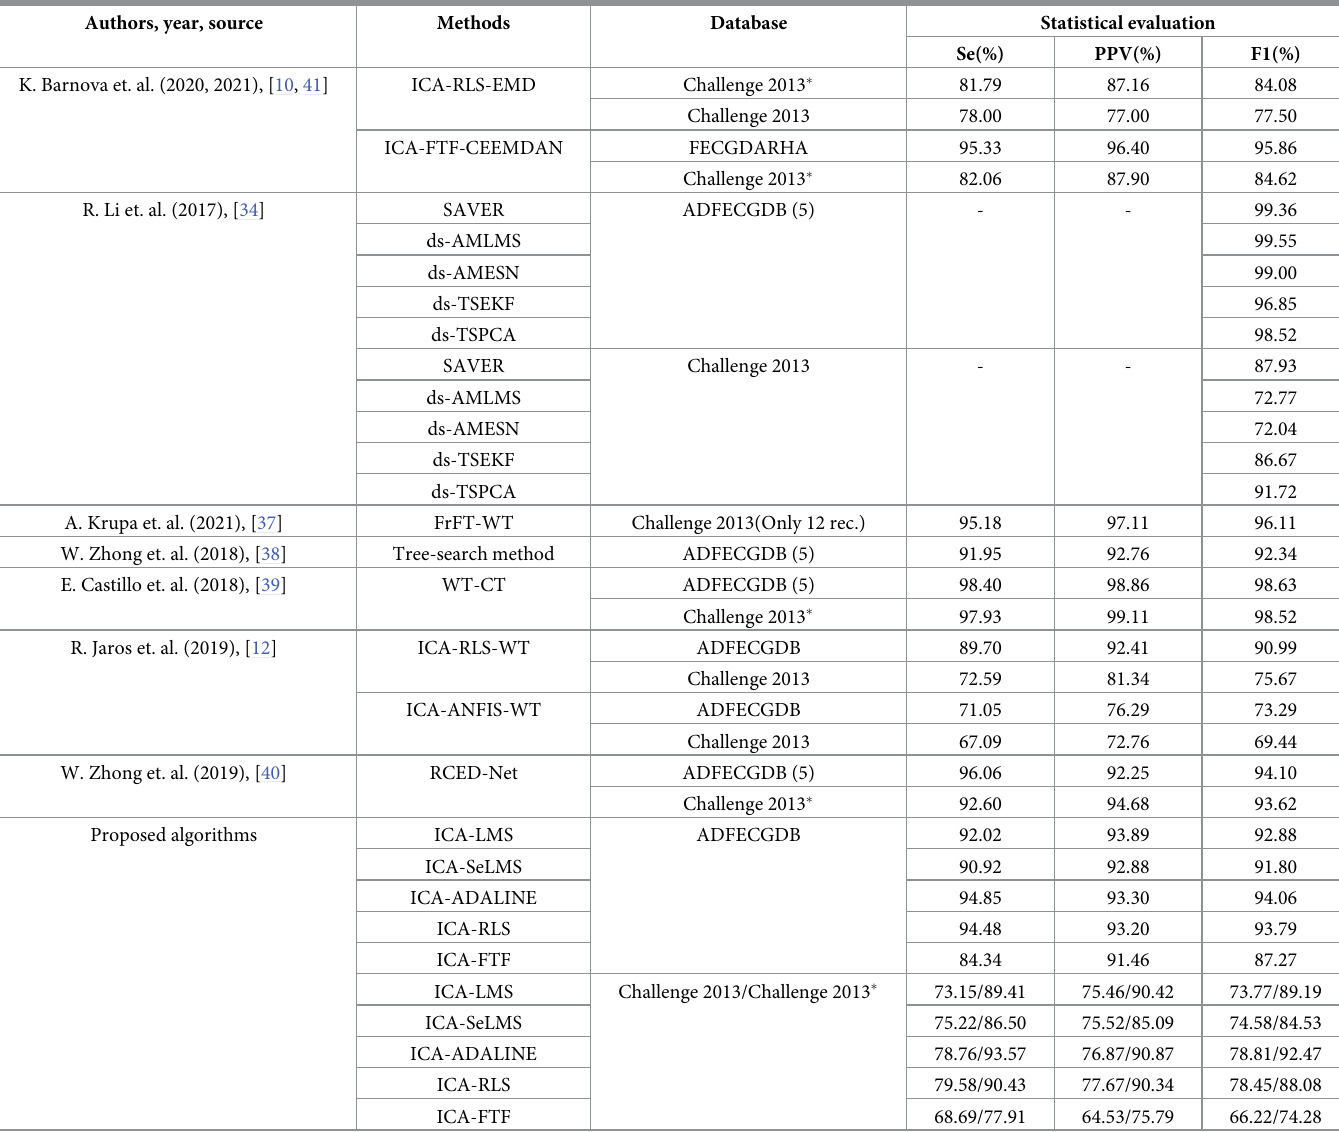
Table 5. Comparison of the proposed algorithms with other